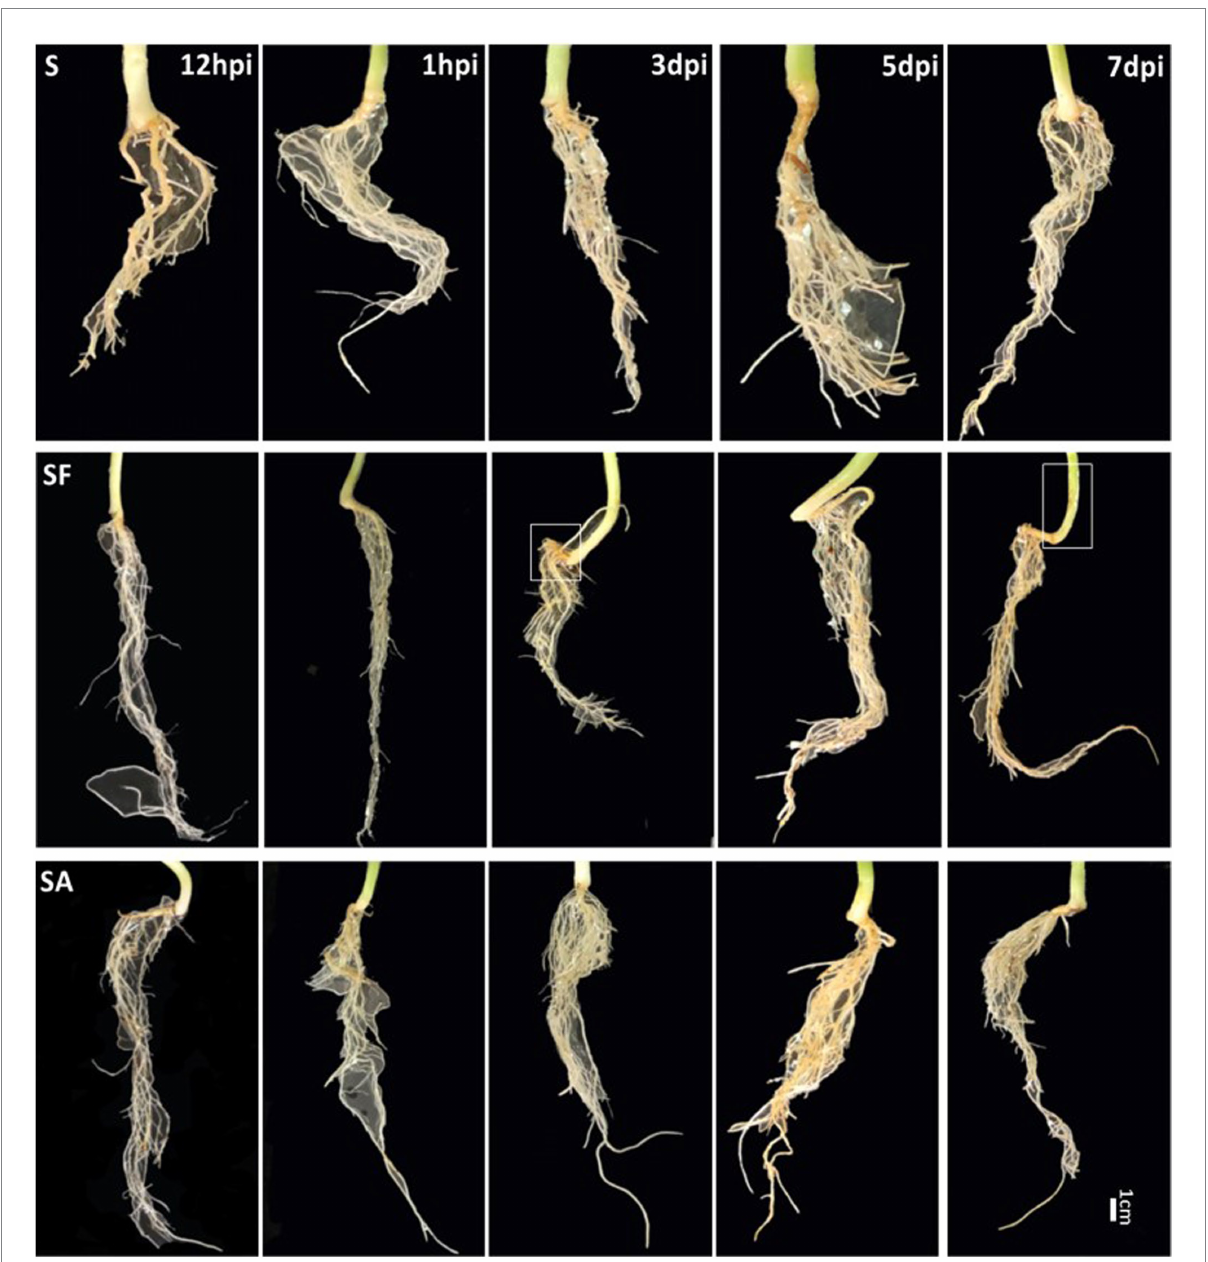
FIGURE 1 Comparison of watermelon root phenotypes in different treatment groups S, Mock-inoculation control; SA, SA + FON treatment; SF, FON treatment; FON, Fusarium oxysporum f. sp. niveum ; SA, salicylic acid; hpi, hours post-inoculation; dpi, days